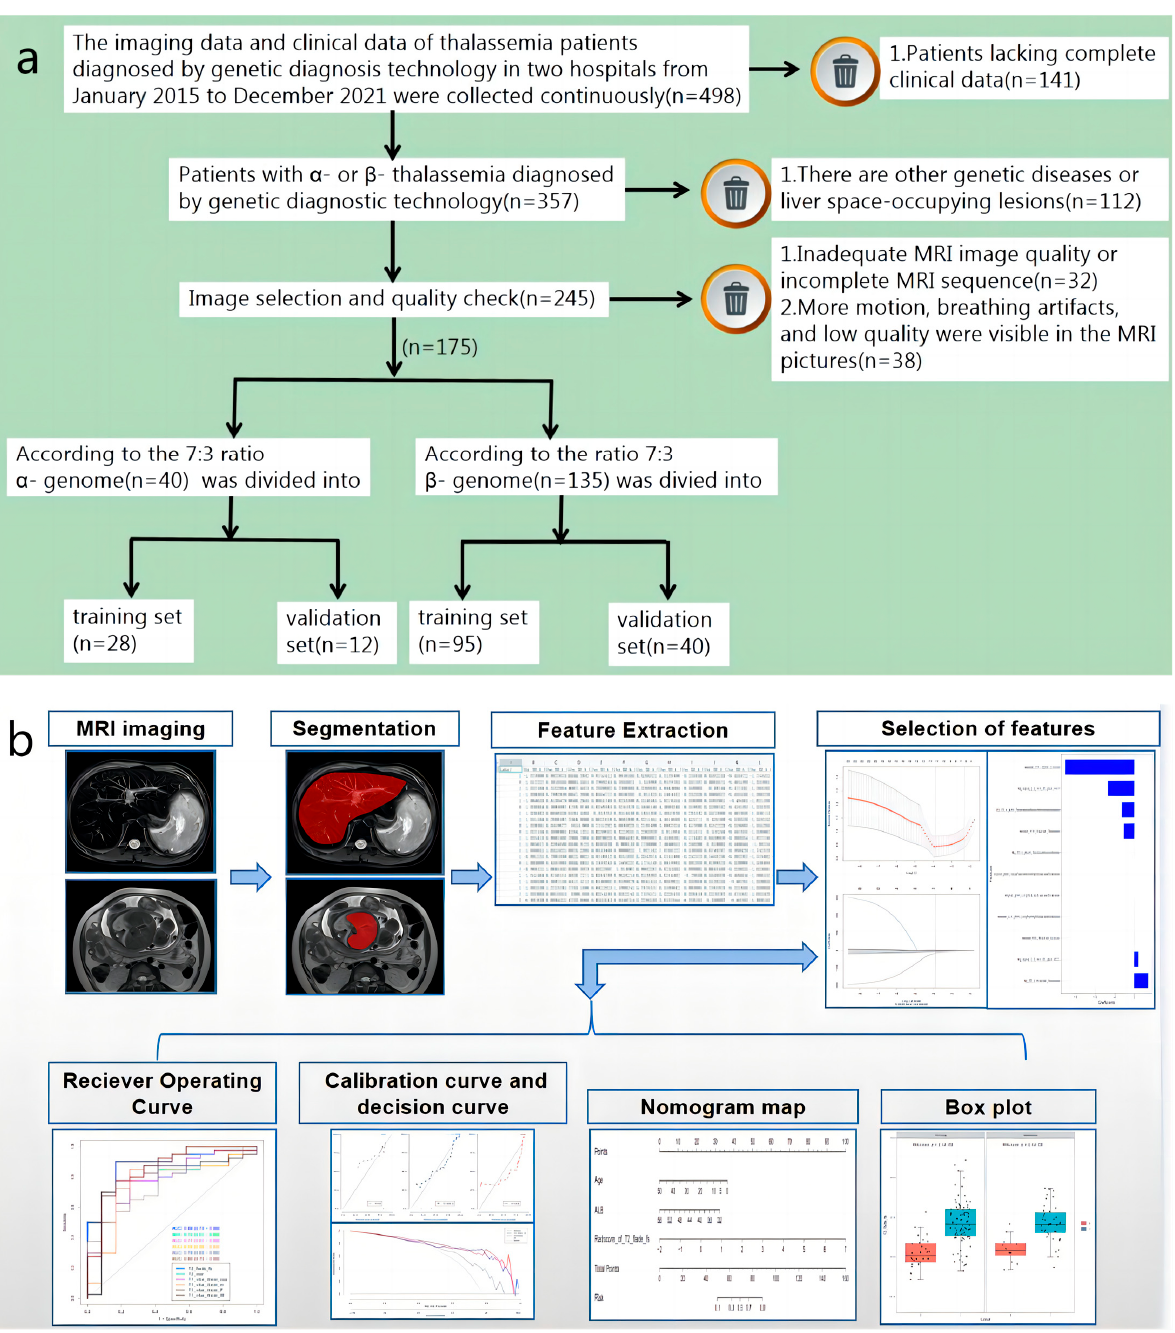
Figure 1. ( a ) A simplified flow chart of the patient selection process. ( b ) A simplified flow chart for constructing the MRI image feature model to predict α -and β -genotypes in TM patients.